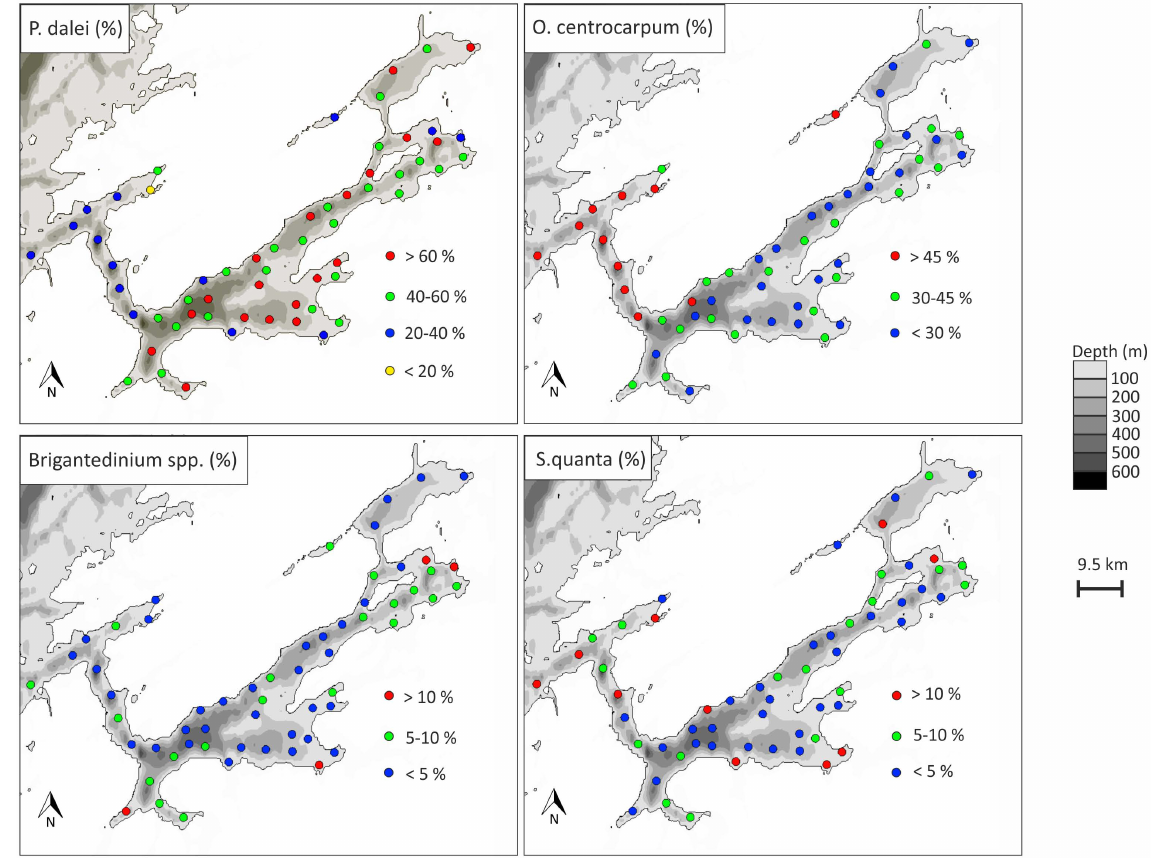
Fig. 8. Relative distribution of the dominant and subordinate cysts in the